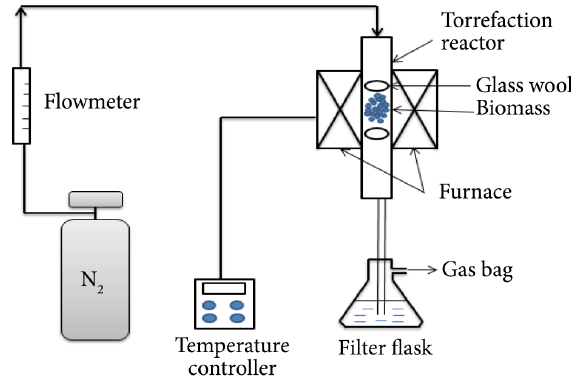
Figure 1. Schematic diagram of the experimental